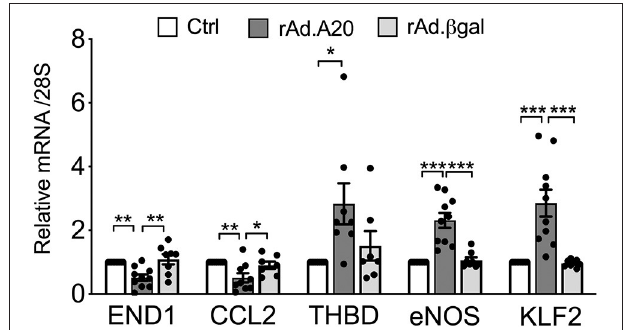
FIGURE 5 | Overexpression of A20 in HCAEC modulates the expression levels of KLF2-dependent genes to increase EC homeostasis. mRNA levels of endothelin-1 (END1), chemokine C-C motif ligand 2 (CCL2)/monocyte chemoattractant protein-1 (MCP1), thrombomodulin (THBD), eNOS, KLF2, and A20 were measured by qPCR in non-transduced HCAEC (Ctrl) and HCAEC transduced with rAd.A20 or control rAd. β gal. Data were normalized by the 28S HKG and expressed as mean ± SEM fold change of Ctrl ( n = 8–10). * p < 0.05, ** p < 0.01, *** p < 0.001, as determined by one-way ANOVA followed by Tukey post hoc test.